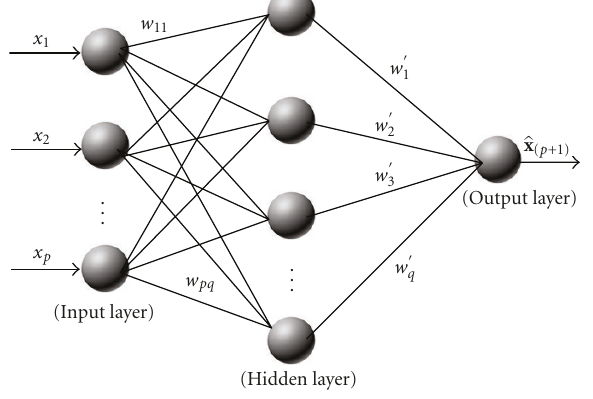
Figure 2: MLP used as a nonlinear predictor. tests. It was found that the architectural configuration of 4-7-1 with 4 input neurons, 7 hidden layer neurons, and 1 output layer neuron yields the best performance results. With (cid:9) q w (cid:2) b (cid:2) , q is the number of hidden this, we need to send only 35 weights (28 hidden layer and 7 where Net o = j = 1 out hj j + output layer weights) and 8 biases for setting up an identical layer neurons. network configuration at the receiving end. Assuming that 32-bit floating-point representation is used for the